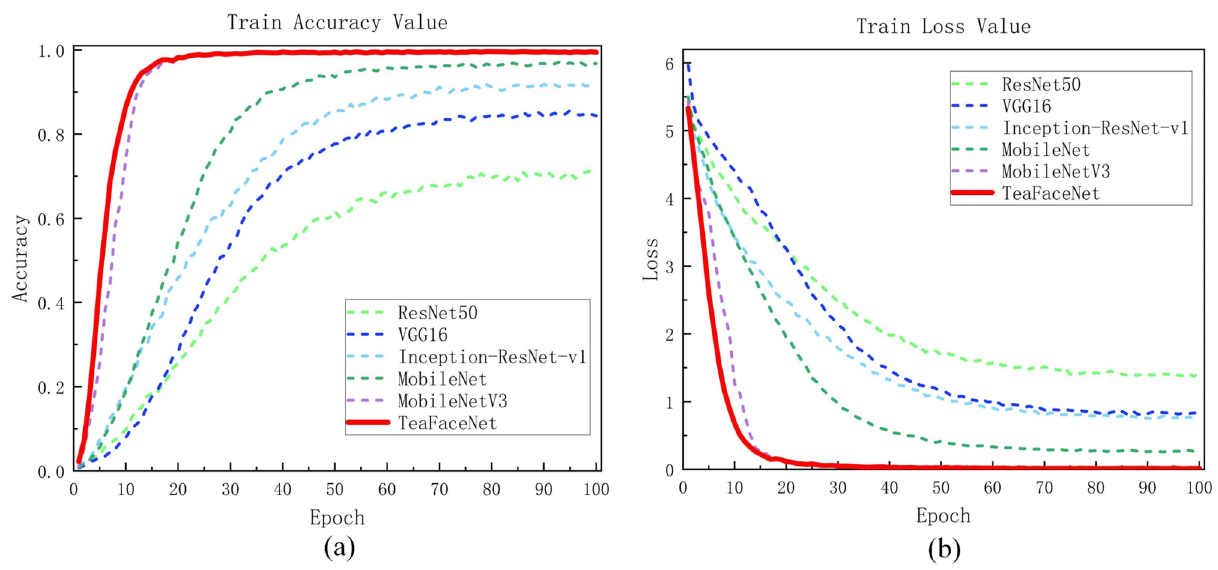
Figure 12. Loss and accuracy of ripe tea